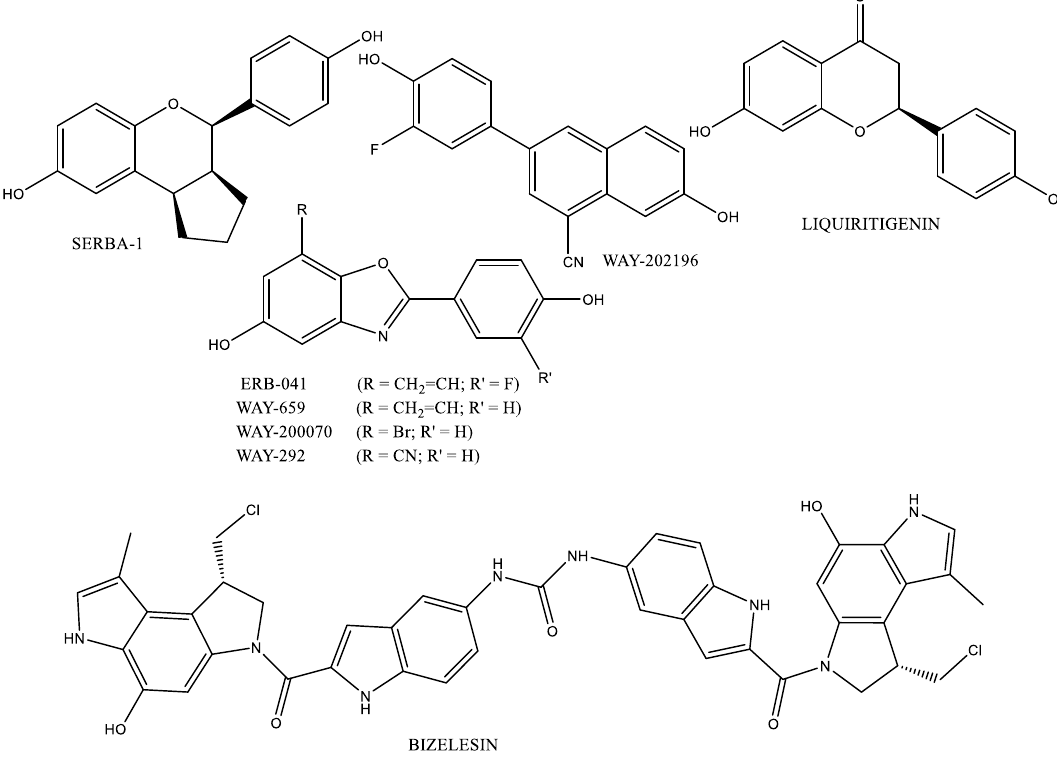
ff erent classes of organic compounds. Molecules 2020 , 25 , x FOR PEER REVIEW 4 of 15